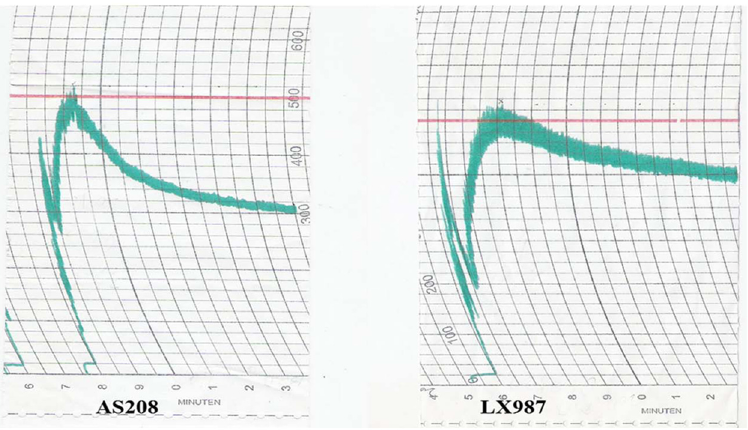
Fig 5. Comparison of Farinograph for AS208 and LX987. The dough formation time and the stabilization time for AS208 (left) were both shorter than the LX987 times (right) during noddle and bread processing. The grains were harvested in Beijing in